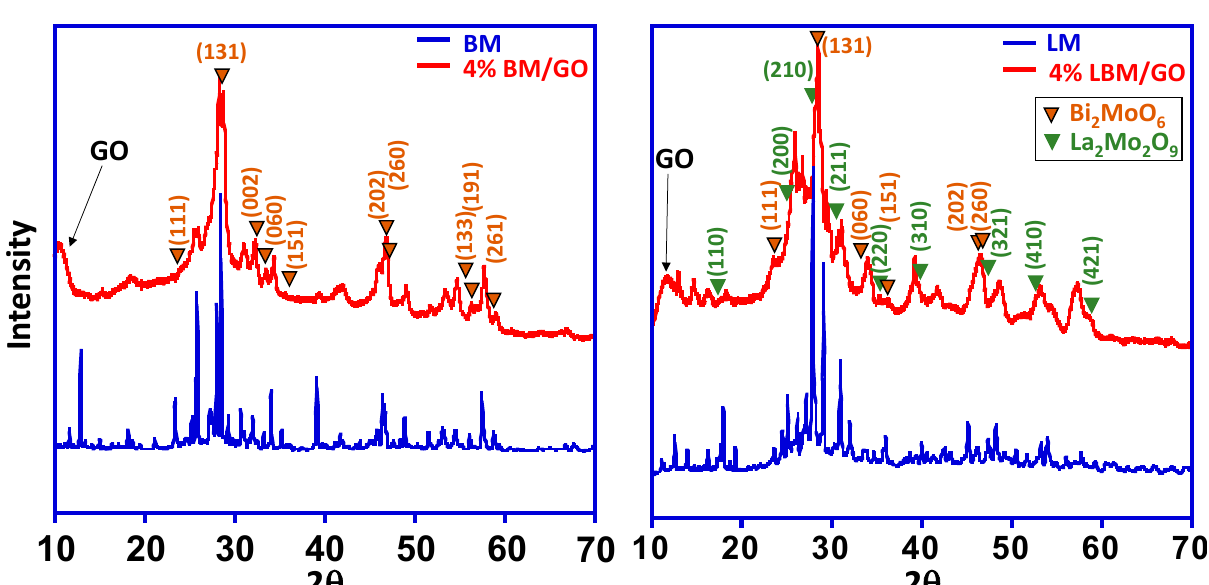
(3.4077 m 2 /g), respectively [28]. This difference in surface area can also be attributed to the